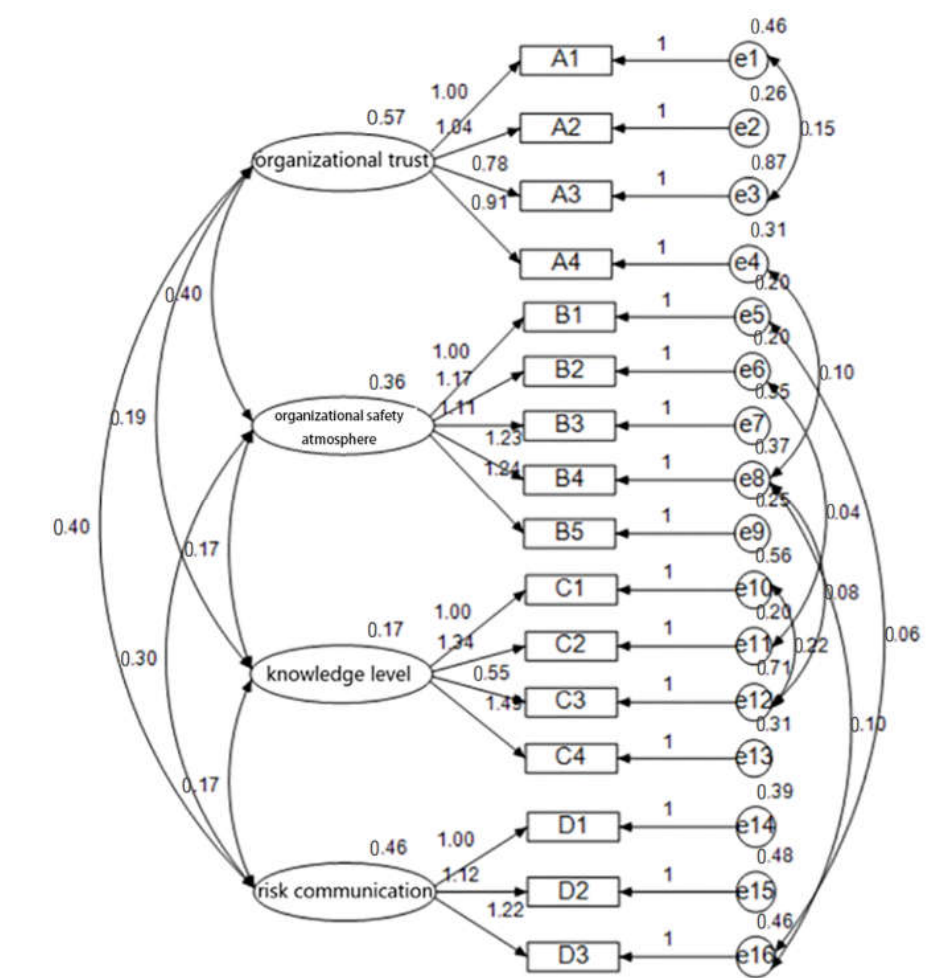
Figure 1. Data results of the modified model of risk perception influencing factors. Table 2. Assumed model-fitting indicators of influential factors of miners’ risk perception.